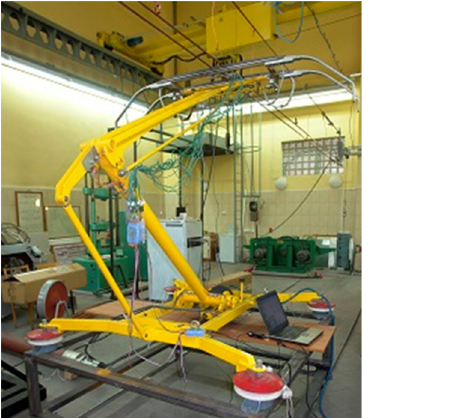
Figure 1. Pantograph equipment is used for research and contact strip material testing [21].